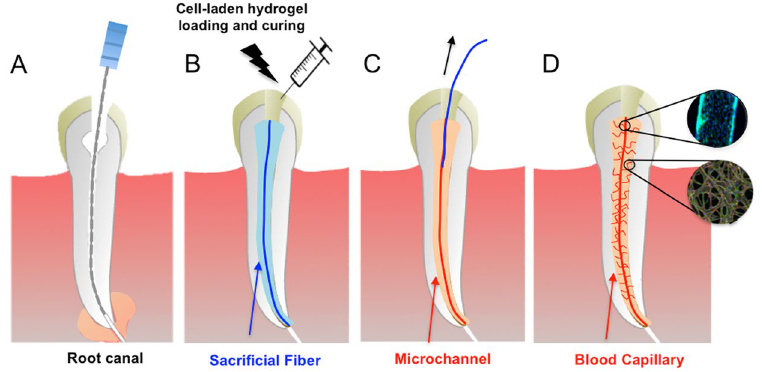
Figure 1. Schematic diagram illustrating the basic steps of the proposed strategy to engineer pre-vascularized full-length dental pulp-like tissue constructs. ( A ) The root canal is prepared following common endodontic procedure using endodontic files. ( B ) A pre-made sacrificial fiber is positioned in the root canal. A cell-laden hydrogel is loaded into the canal and photopolymerized. ( C ) After the hydrogel photopolymerization, the sacrificial fiber is removed, creating a hollow microchannel that traverses the entire length of the canal, from the apex through the pulp chamber. ( D ) Endothelial cells are seeded in the fabricated microchannel to engineer the core vascular capillary in the dental pulp, thus resulting in a pre-vascularized full-length dental pulp-like tissue construct. Details are provided in Supplementary Figure